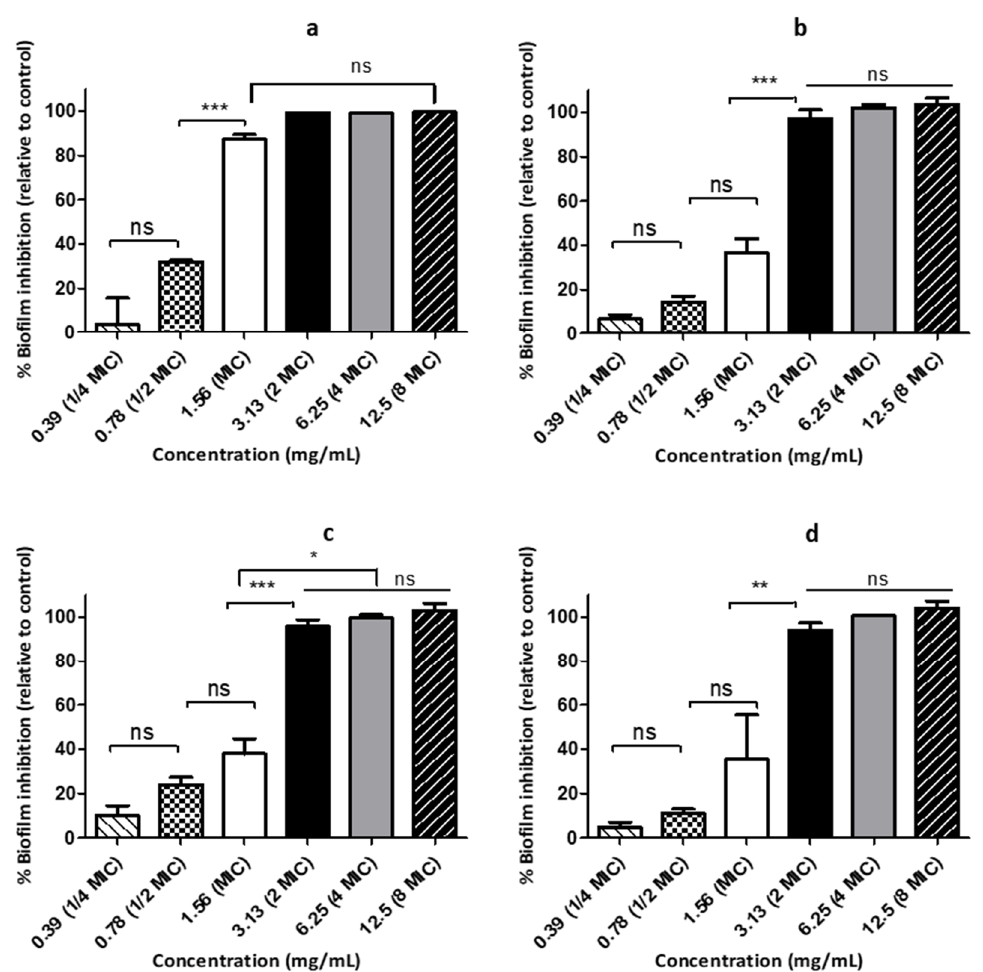
Figure 4. Inhibition of biofilm formation of Streptococcus pyogenes 19615 by hot water infusions at various concentrations. ( a ) licorice roots, ( b ) barberry roots, ( c ) oregano flowering shoots, and ( d ) thyme flowering shoots. Each data point represents mean ± SD from three independent experiments performed in triplicate.